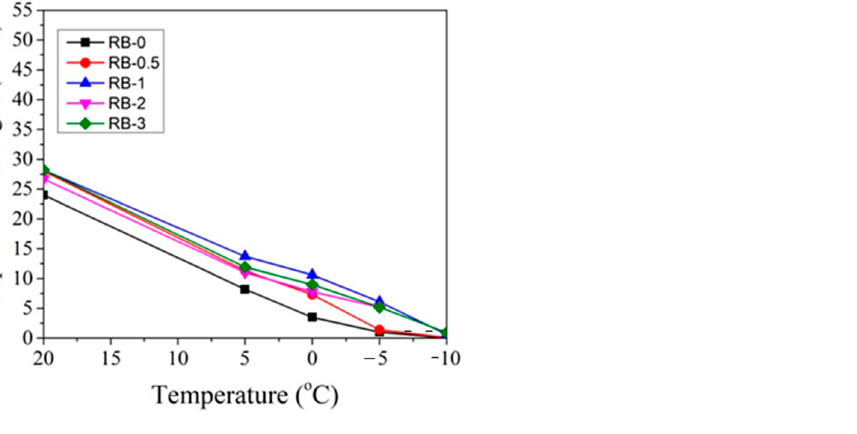
Figure 19. Compressive strength of concrete with CEM IIR after 2 days as a function of initial curing temperatures (°C) for CN dosages in the range from 0% to 3%.